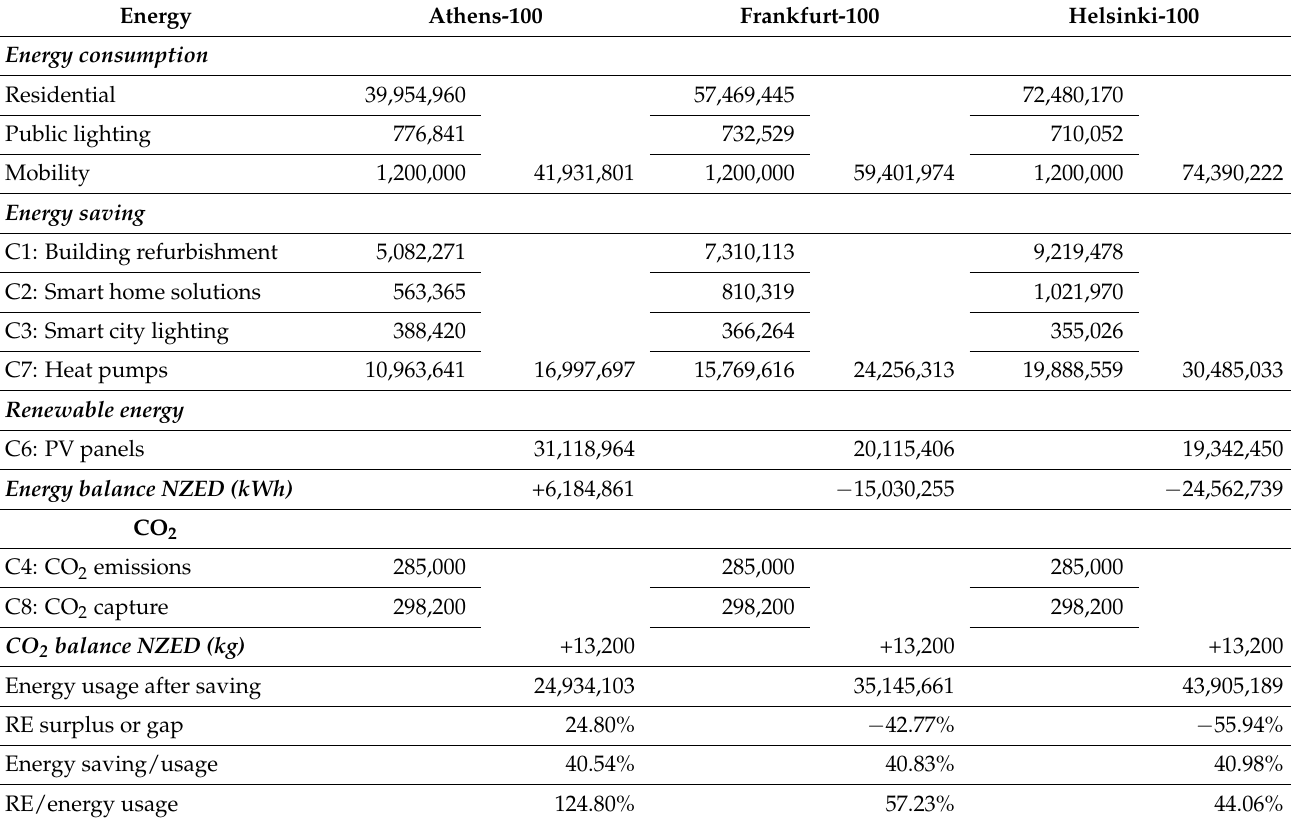
Table 7. Outcome of baseline NZED scenario in Athens, Frankfurt, and